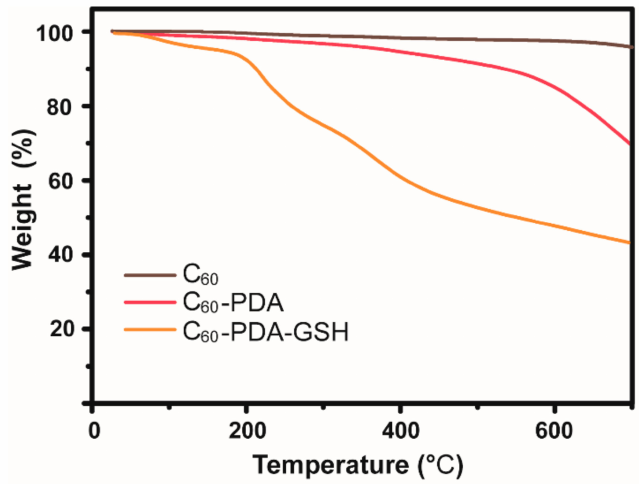
Figure 3. TGA curves of C 60 , C 60 -PDA and C 60 -PDA-GSH,